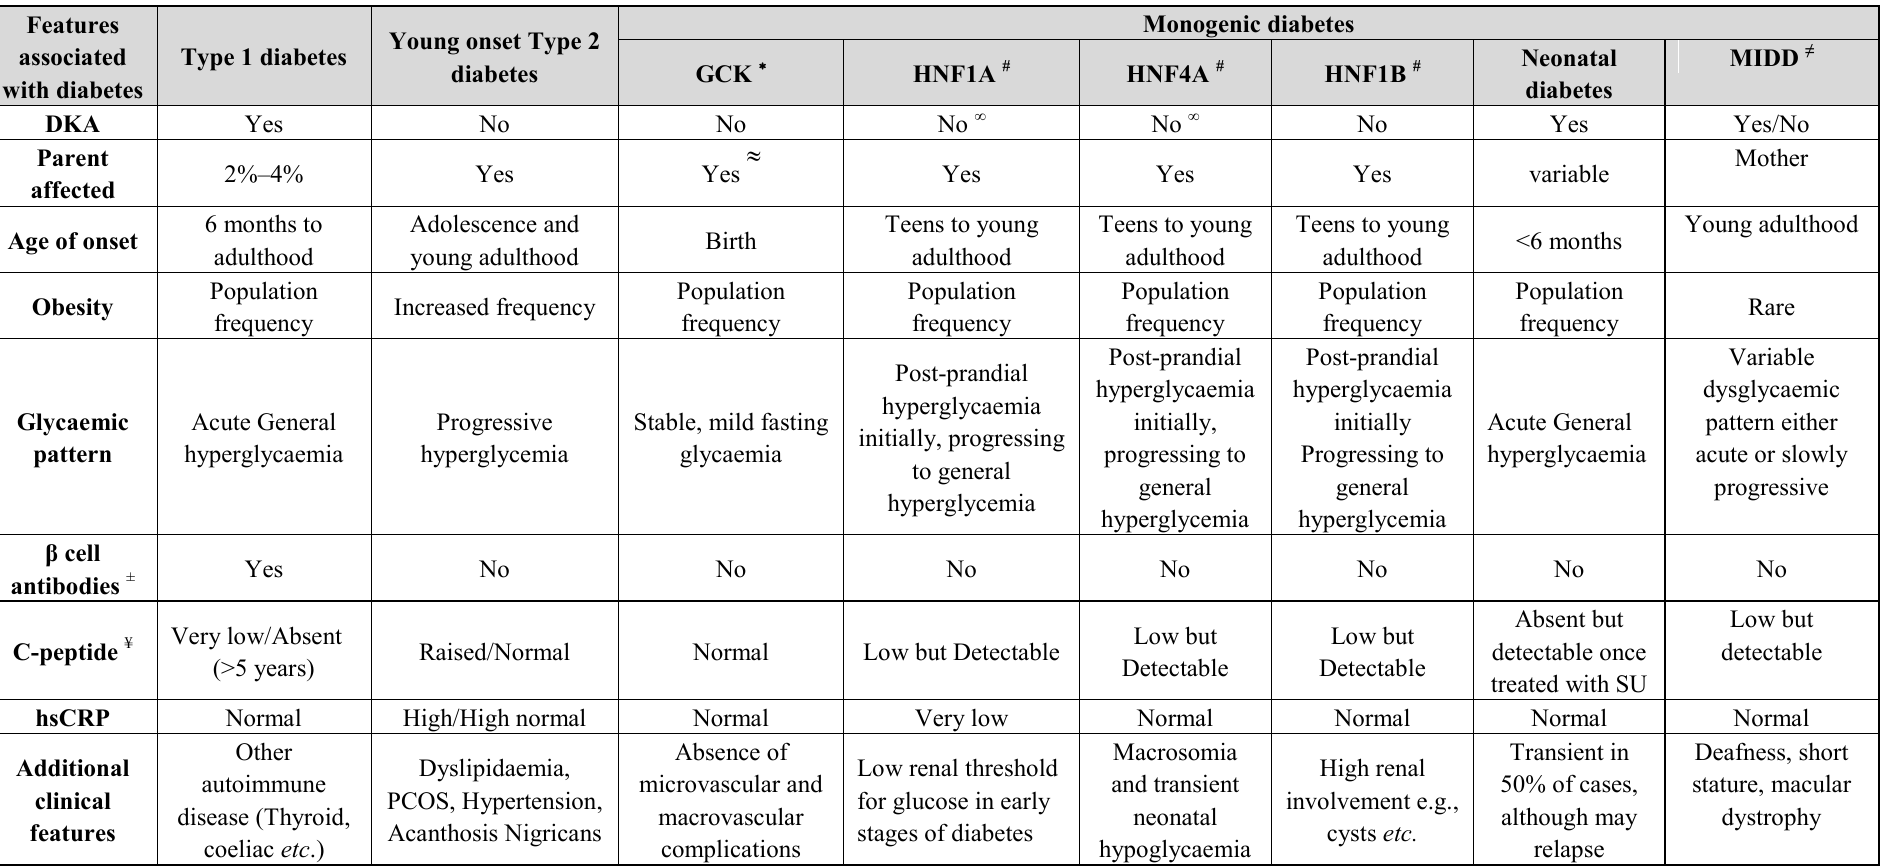
Table 1. Characteristic Phenotypes of the commonly encountered diabetes subtypes, illustrating the clinically useful differences between type 1 and type 2 diabetes, and monogenic forms of